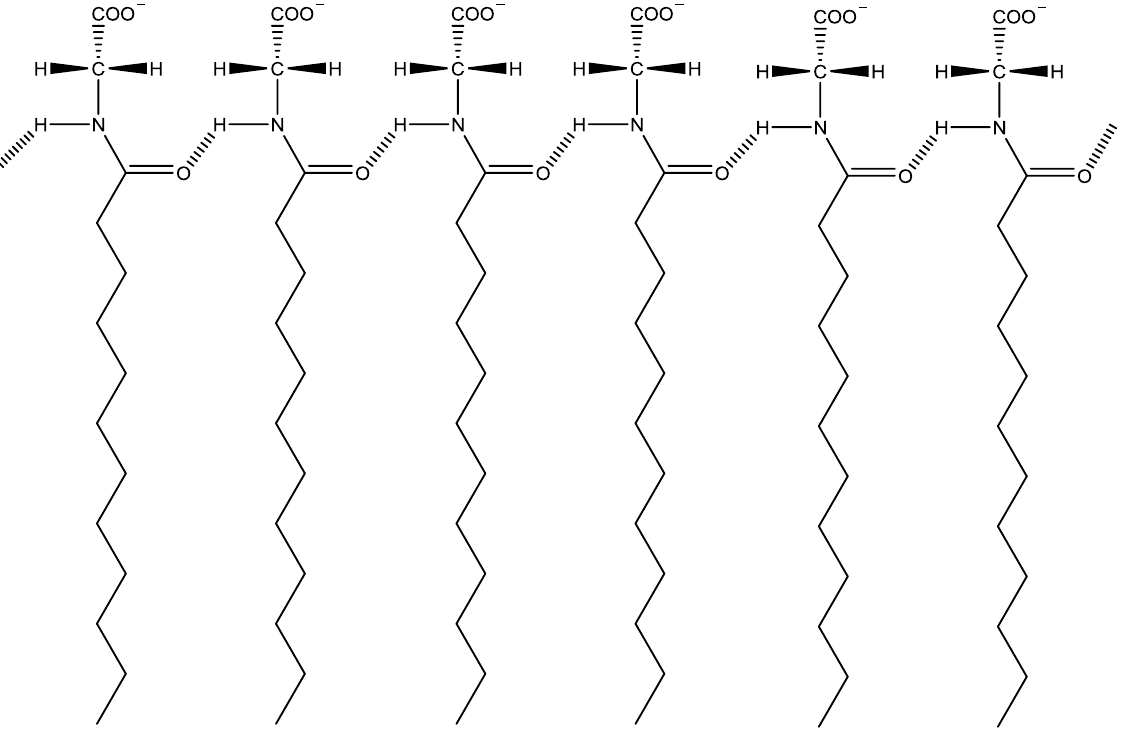
Figure 9. Molecular arrangement of the KDDGly molecules. The hashed bonds between –C=O and –N–H correspond to the hydrogen